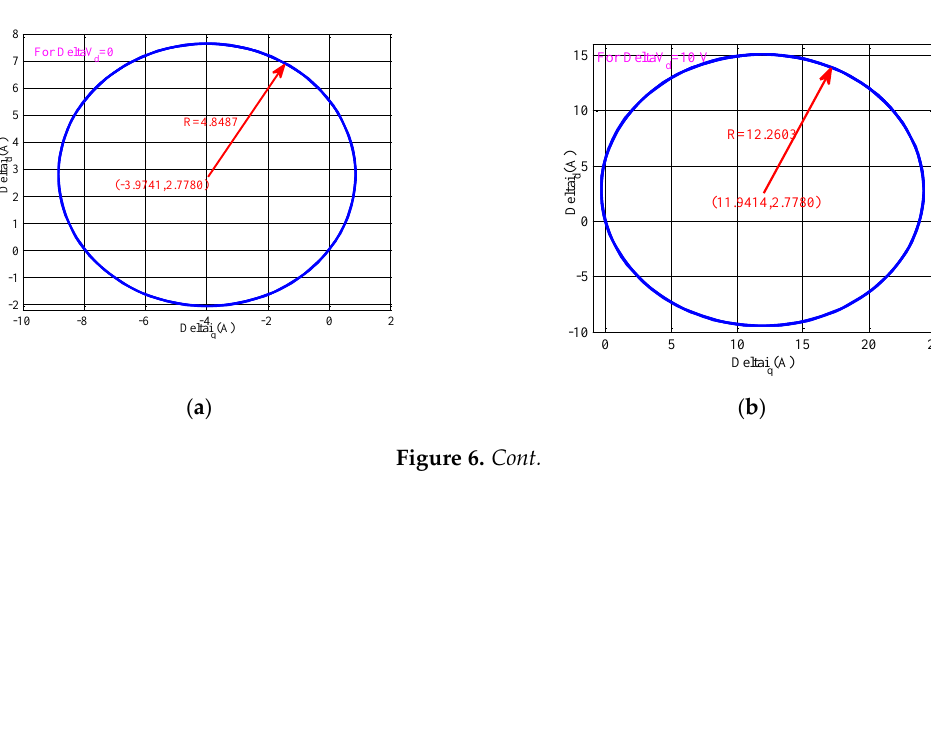
Figure 5. Effects of grid frequency error variation on the current error curve: ( a ) ∆ ω = 0 Hz; ( b ) ∆ ω = 0.2 Hz; ( c ) for various grid frequency errors.